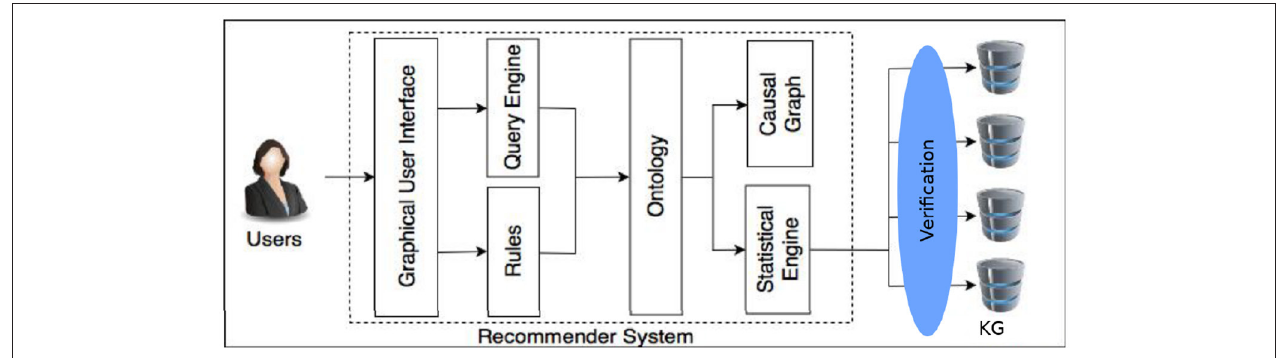
FIGURE 10 | A schema of the recommender system (Brenas et al.,